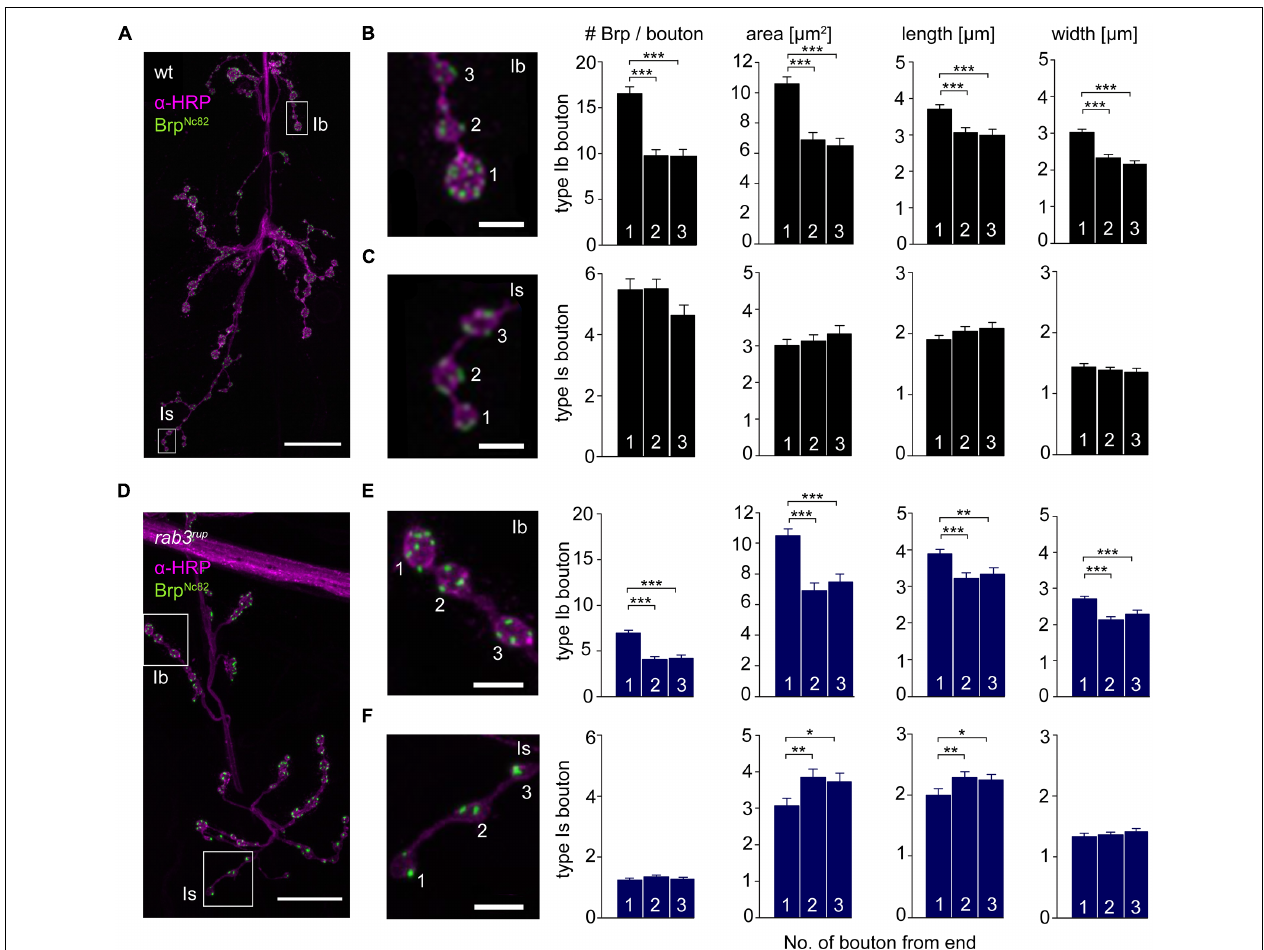
boutons. (D) Drosophila rab3 rup NMJ as in (A) . Neurite passing by the NMJ at the top. (E,F) Magnification of boxed regions in (D) show the terminal three boutons of respective type Ib and type Is endings. Summary bar graphs for the number of Brp puncta per bouton and area, length and width of the terminal three boutons. Scale bars = 20 μ m (A,D) and 5 μ m (B,C,E,F)